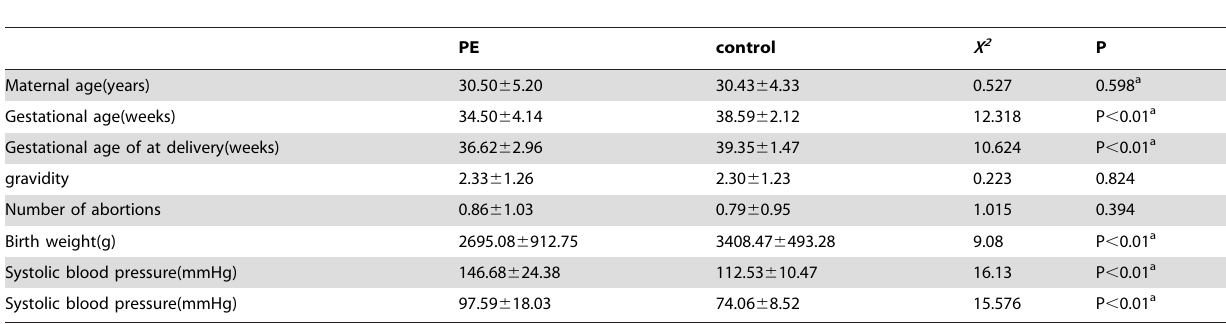
Table 1. Demographic and clinical characteristics of the PE cohort and normal pregnant women.